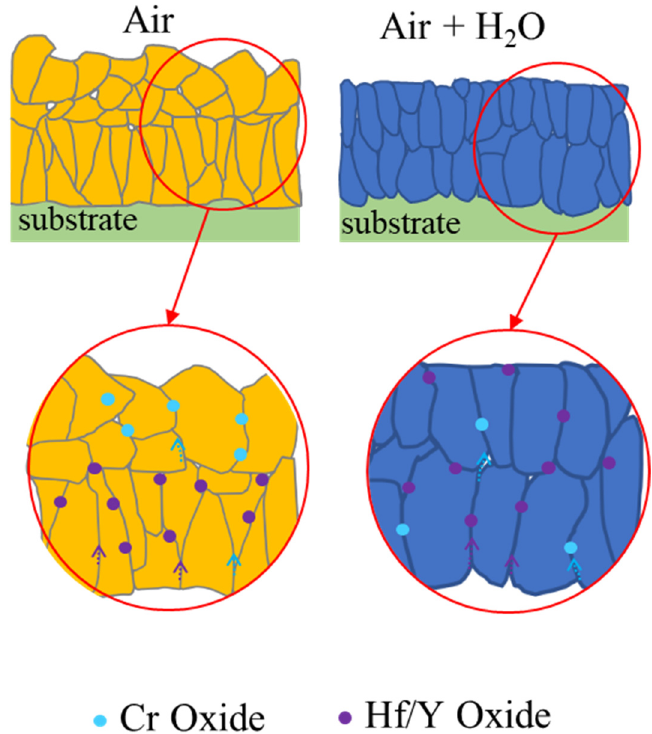
Figure 13. Schematic diagram of the morphology and composition of the oxide scale of NiCrAlYHf alloys at 1100 °C in different atmospheres.